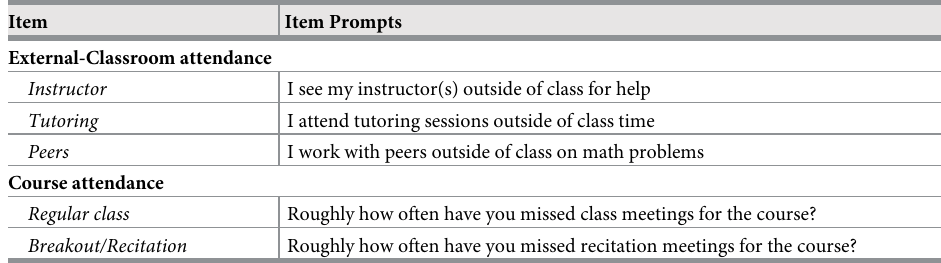
Table 2. Items related to math learning